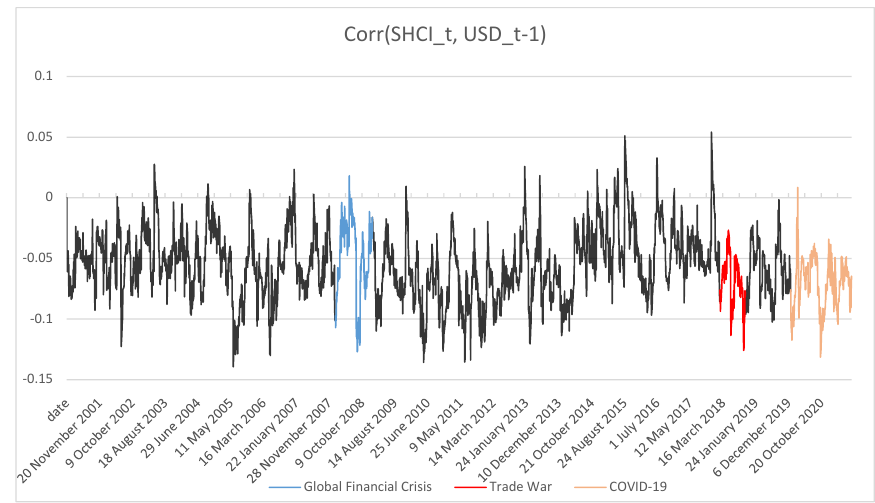
Figure 9. Dynamic correlation between SHCI at t and USD at t - 1